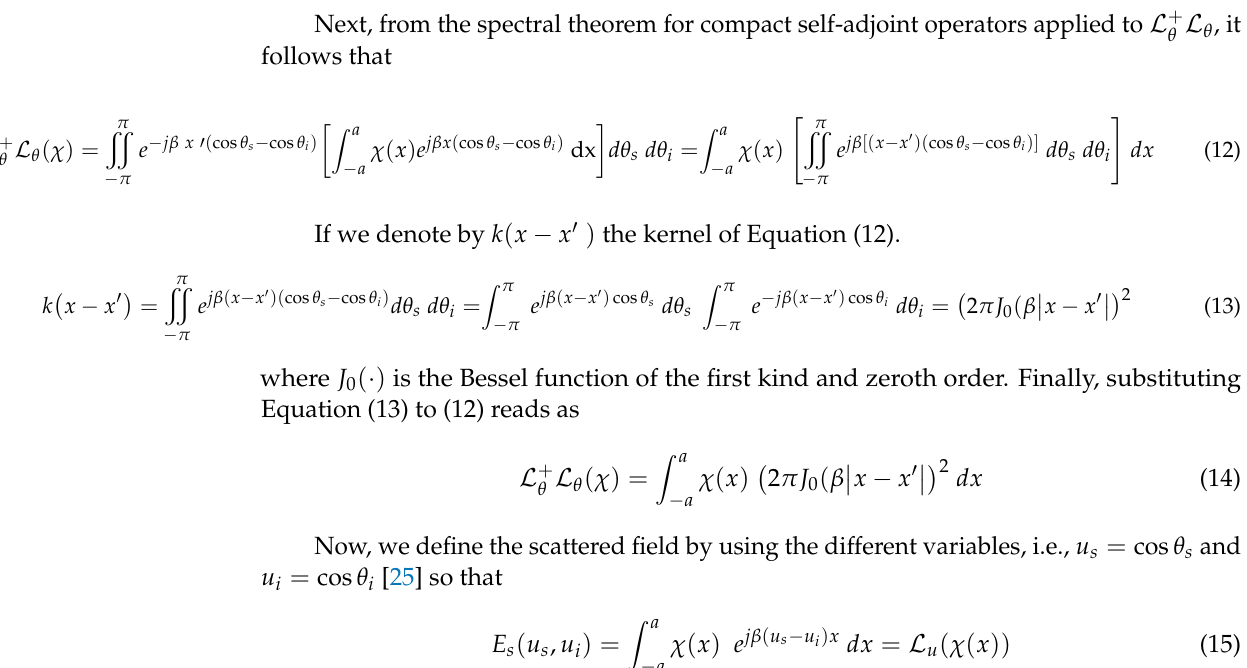
Figure 2. The geometry of the one strip Investigation Domain (ID).